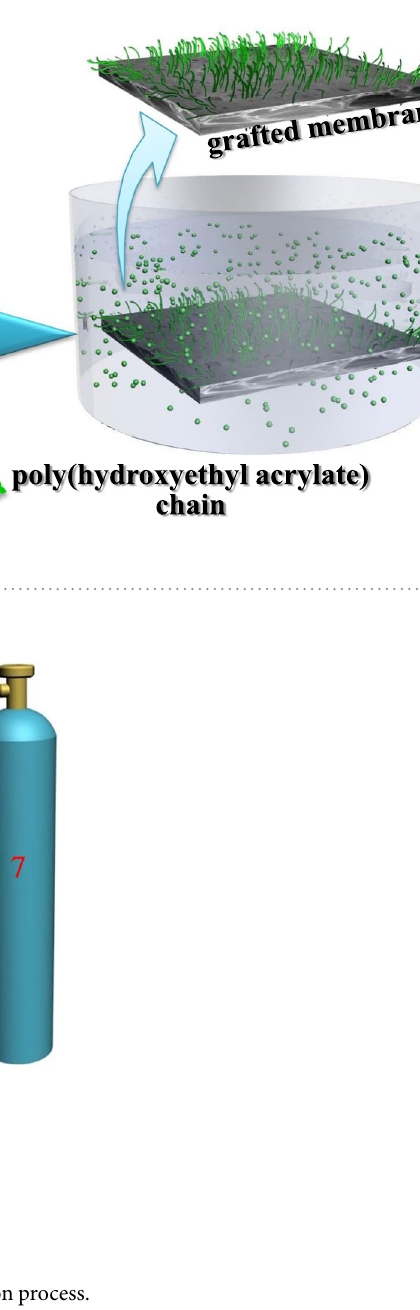
Figure 2. The schematic illustration of the set-up for filtration